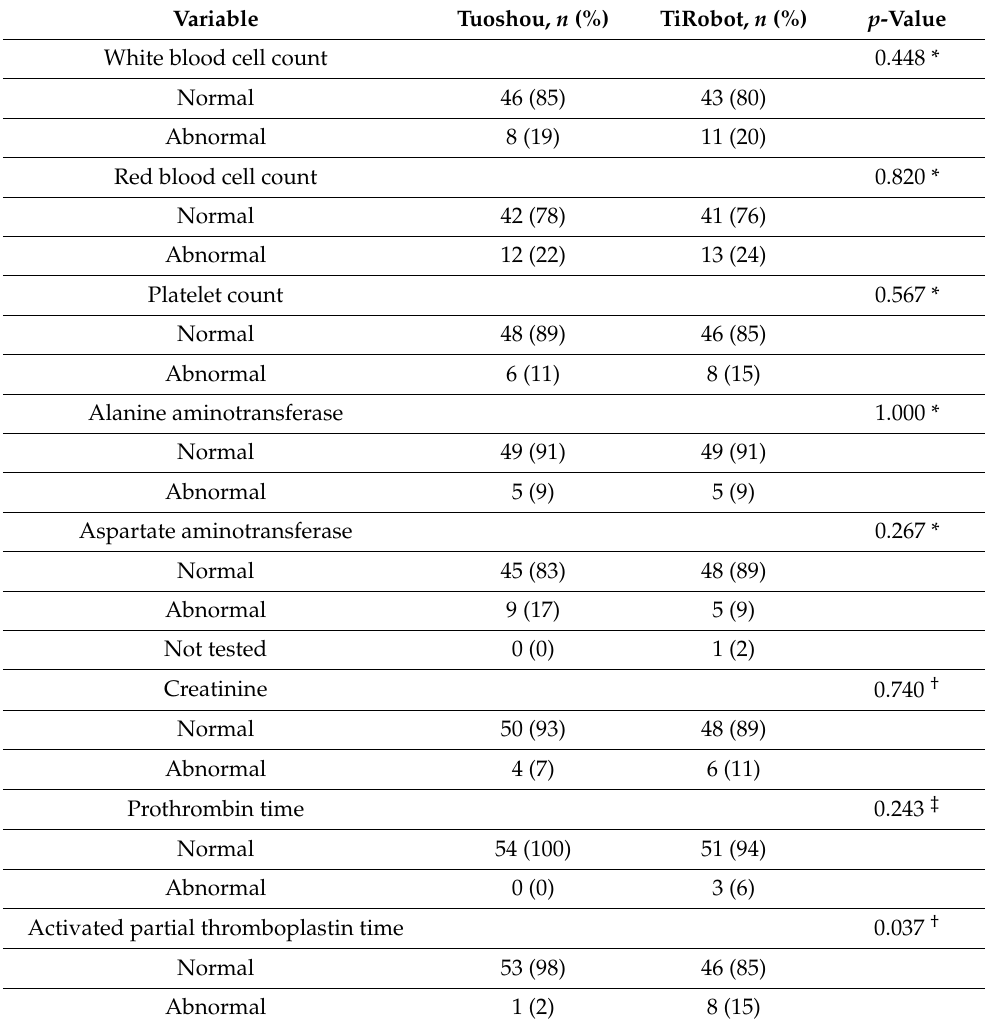
Table 2. Blood test results of two